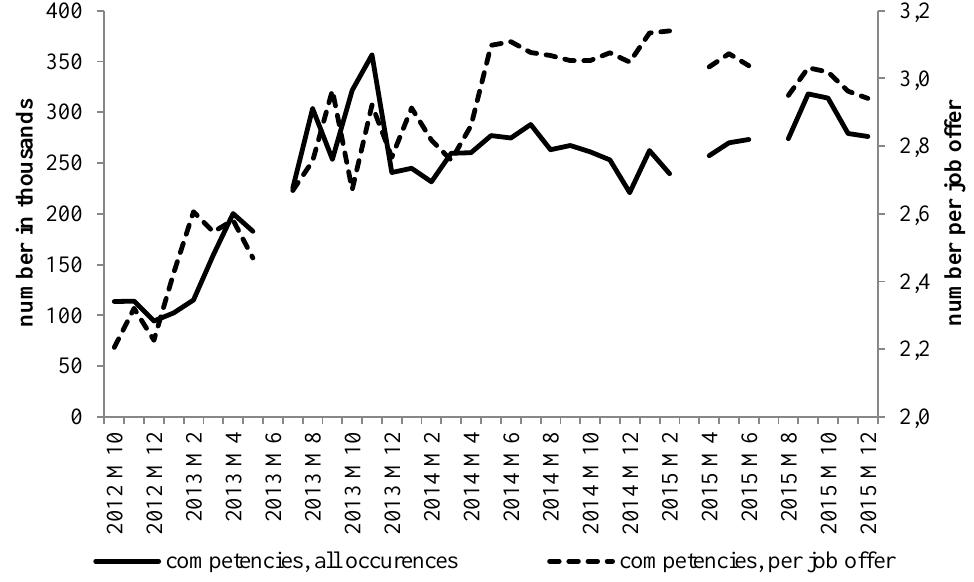
Figure 3 : Transversal competences: all occurrences (left scale) and per job offer (right